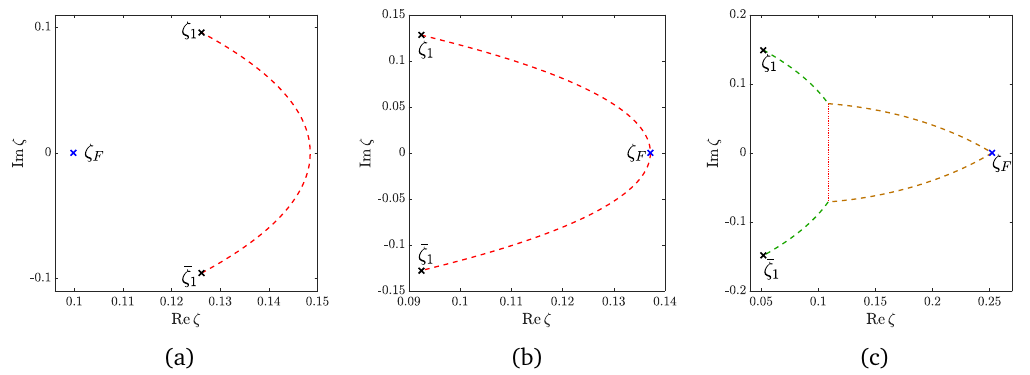
Figure 6: Branch points ( ζ cut solution with anisotropy parameter δ = 1 and various filling fractions ν = { 0.1,0.206354963,1 / 3 } , increasing from left to right. Panel (b) corresponds to the critical filling fraction ν lide with the physical